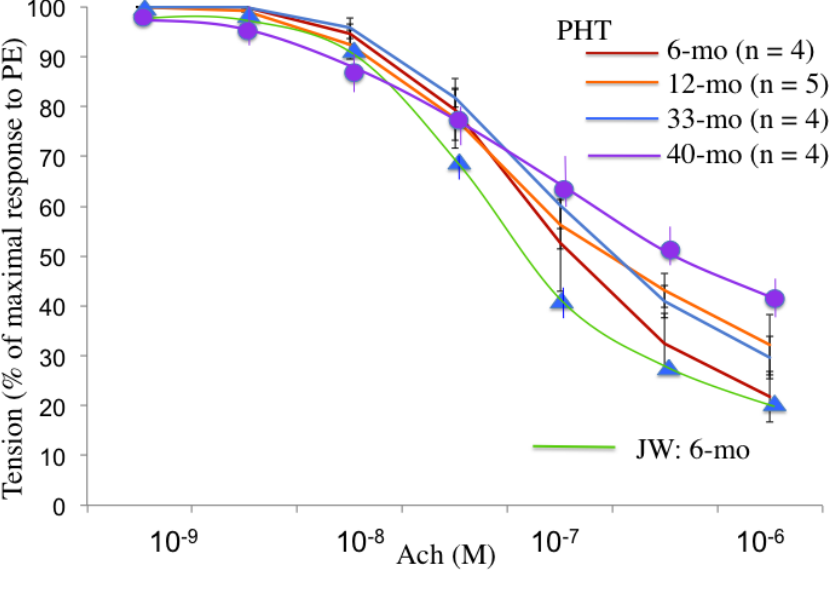
Figure 9. Age-related changes in the acetylcholine-induced endothelium-dependent relaxation of PHT aorta. The acetylcholine-induced relaxation in normal Japanese white rabbits is shown by the green